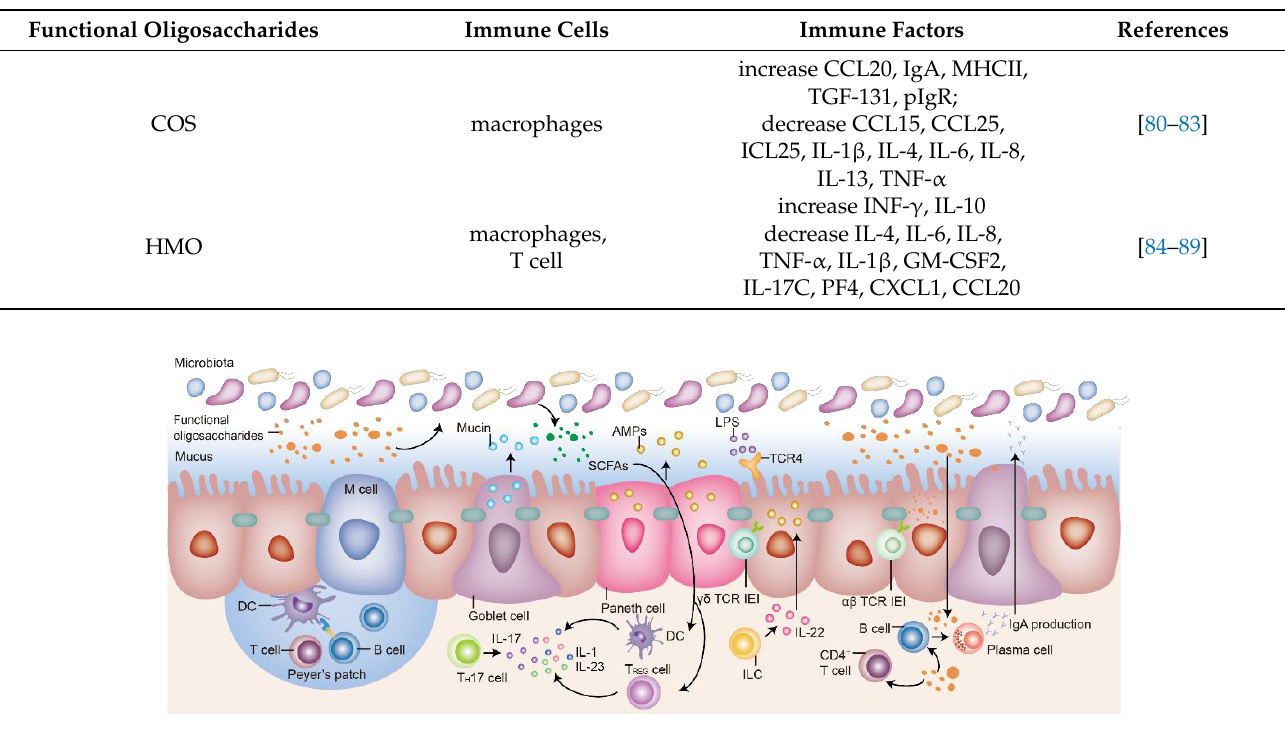
Figure 3. Schematic diagram of the modulating effect of functional oligosaccharides on the intestinal immune barrier. SCFAs: short chain fatty acids; AMPs: antimicrobial peptides; LPS: lipopolysaccharide; M cell: membranous/microfold cell; DC: dendritic cell; T cell: T-lymphocyte cell; B cell: B-lymphocyte cell; Th17 cell: T helper cell 17; IL-1/17/22/23: interleukin 1/17/22/23; Treg cell: regulatory T cell; TCR: T cell receptor; ILC: innate lymphoid cells; CD4+ T cell: cluster of differentiation 4 T cell; IgA: immunoglobulin A. Table 3. The mode of action of common functional oligosaccharides on the intestinal immune bar- rier.